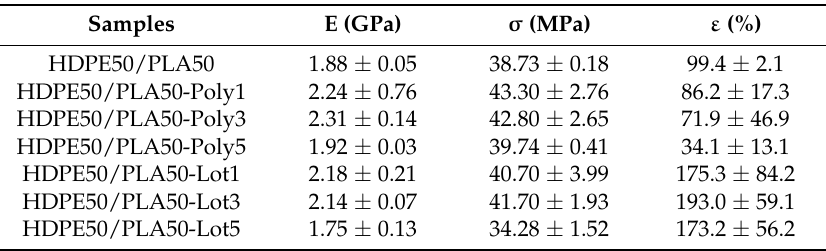
Table 3. Tensile tests results for HDPEPLA blends with Lotader AX8840 and Polybond 3029 in different amounts (1, 3, 5 wt.%). The purple colour indicates or Polybond 3029 addition, while the green colour is for Lotader AX8840.